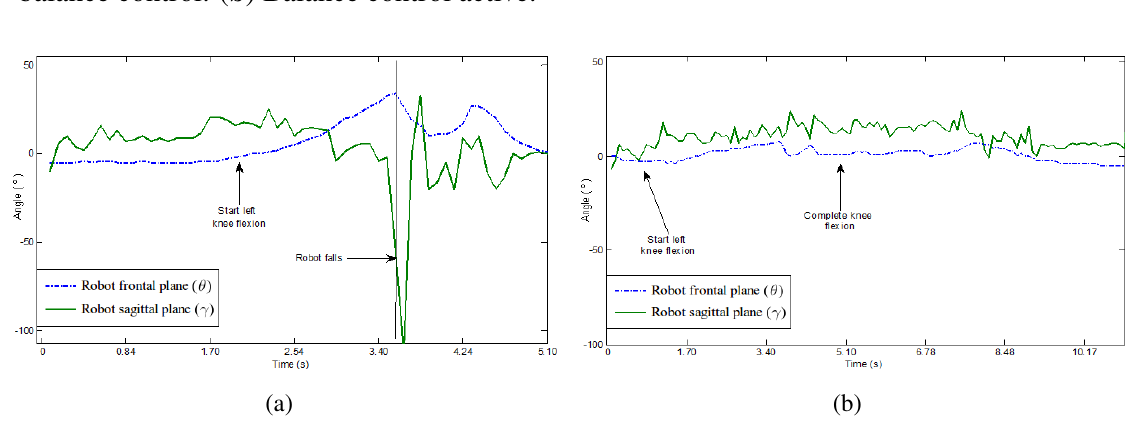
Figure 9. Angular variations in frontal and sagittal planes for a knee flexion exercise. ( a ) No balance control. ( b ) Balance control active.